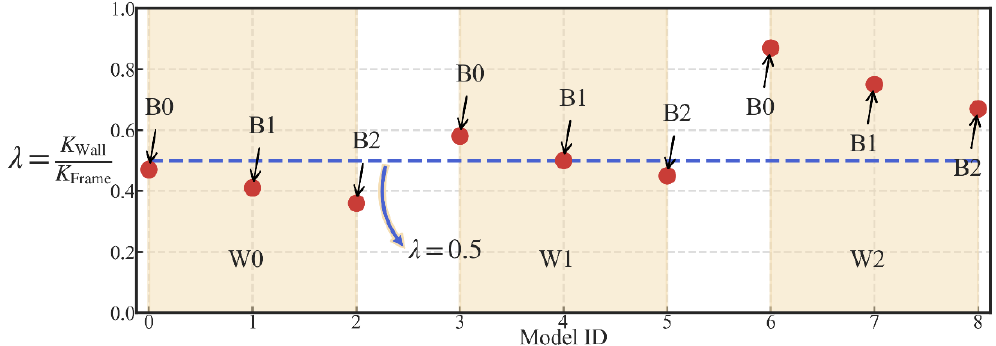
ff ness ratio of the nine